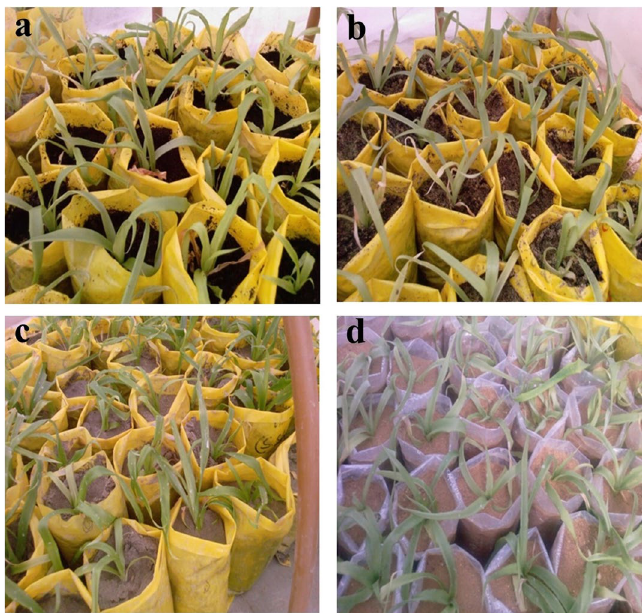
Figure 5. ( a ) Effect of peat moss on vegetative growth of plants in greenhouse ( b ) Effect of peat moss + bolhari ( c ) Effect of river silt ( d ) effect of bolhari.